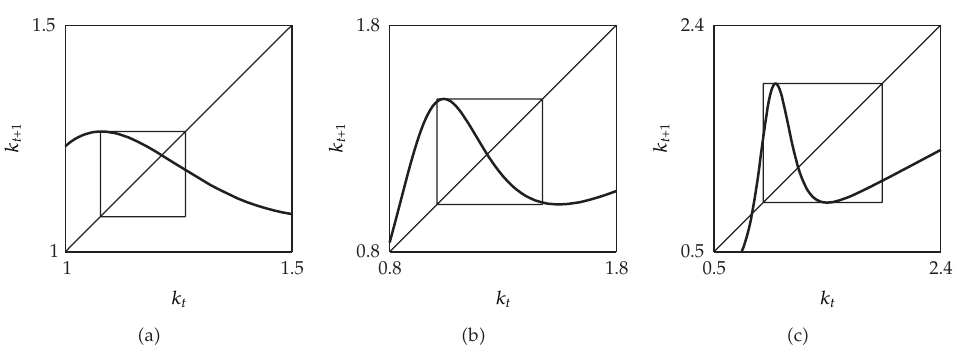
Figure 3: Map F and set S for β (cid:7) 0 . 9, α (cid:7) 1, n (cid:7) 0 . 5, s w (cid:7) 0 . 1 and s r (cid:7) 0 . 7. (cid:3) a (cid:6) p (cid:7) 6 and F S is strictly decreasing; (cid:3) b (cid:6) p (cid:7) 8 and F S is unimodal (cid:3) the maximum point belongs to S (cid:6) ; (cid:3) c (cid:6) p (cid:7) 12 and F S is bimodal (cid:3) both k (cid:6) M and k m belong to S